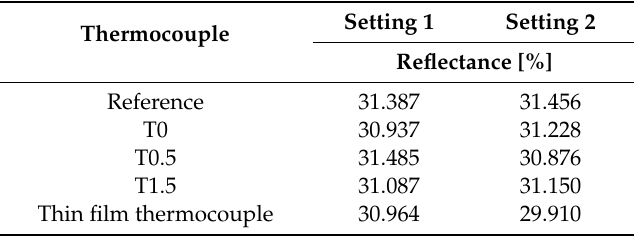
Table 3. Results of the reflection results in dependence of the used thermocouple.